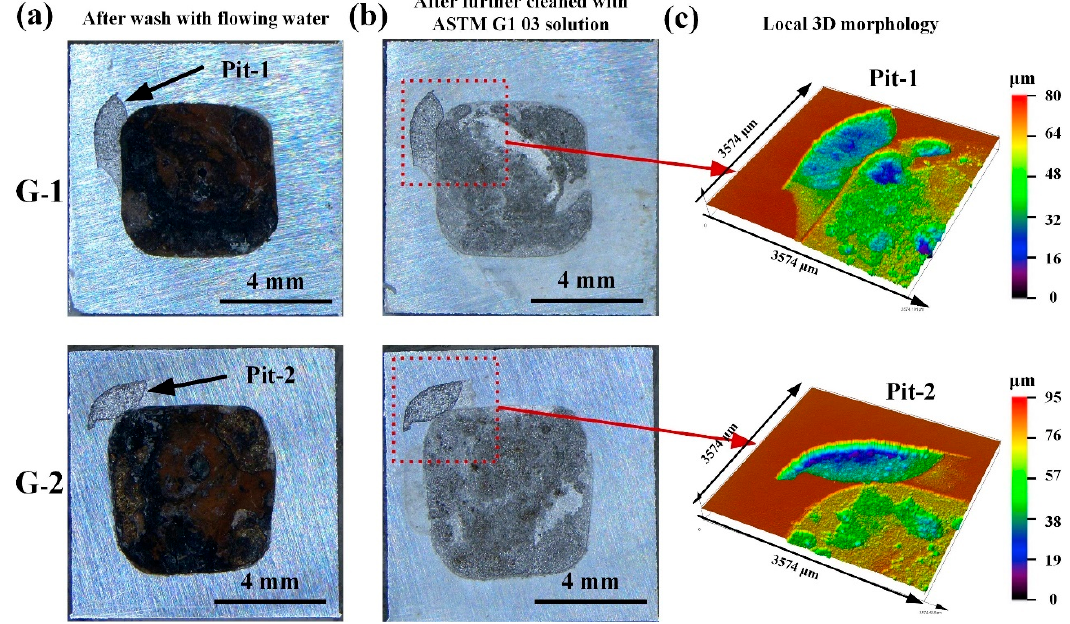
Figure 5. The surface morphologies of independent two pre-rusted coupons ( a ) after removal of newly corrosion product, ( b ) after removal of original rust layer, and ( c ) the local 3D profiles of the steel coupon.